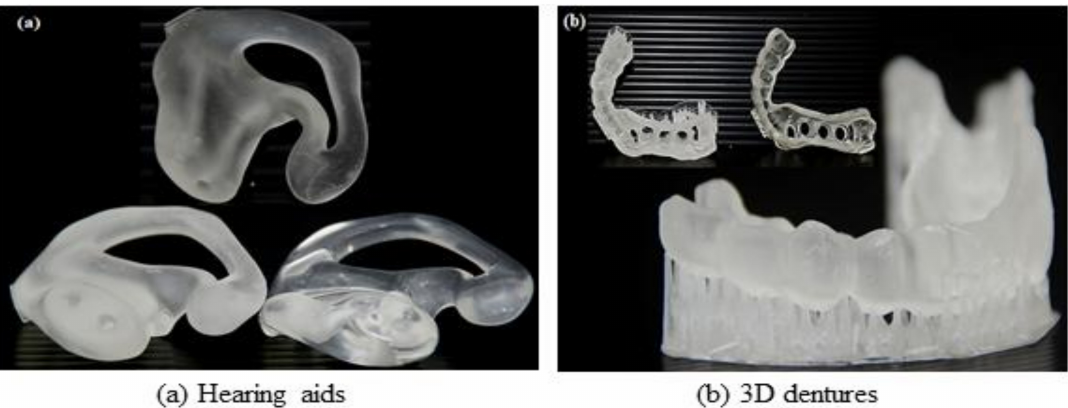
Figure 14. CAD model design using microstereolithography technique for ( a ) hearing aids and ( b ) 3D dentures. Source: Adapted from Tajau and Talib